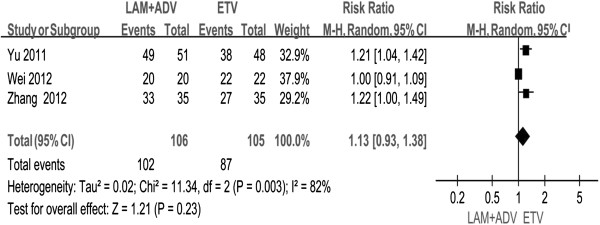
Effect of LAM + ADV vs. ETV at 96 weeks on virologic response.